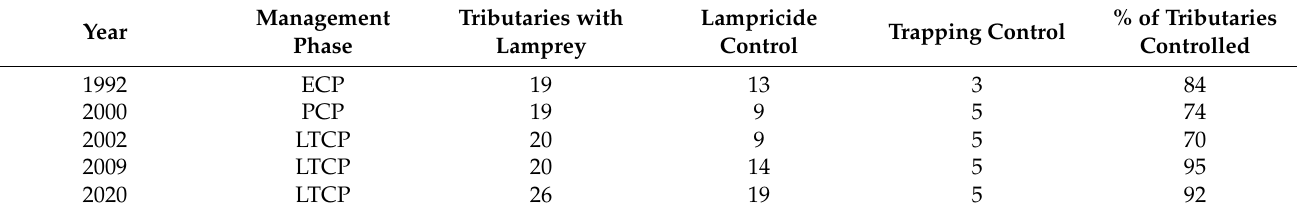
Table 1. Historical levels of chemical (lampricide) and physical (barriers with traps) sea lamprey control efforts used on Lake Champlain. Lamprey-producing subordinate tributaries controlled concurrently with mainstem tributaries are not included in counts. ECP = experimental control program; PCP = partial control program; LTCP = long-term control